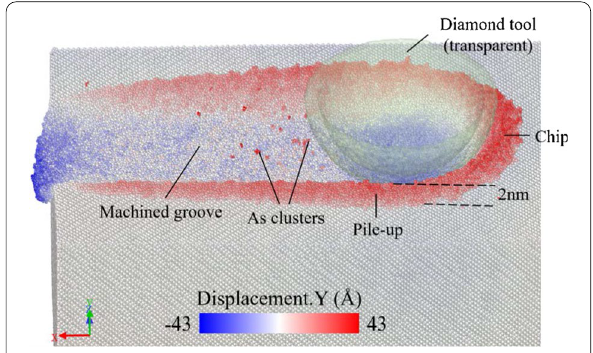
Fig. 3 Nano-cutting simulation result colored with the atom’s displacement in the y -direction